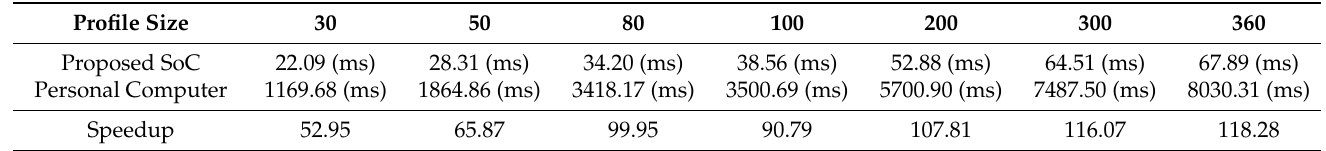
Table 6. The total latency t 1 for finding the optimal bandwidth allocation x ∗ for various profile sizes p over search space B given a profile P .